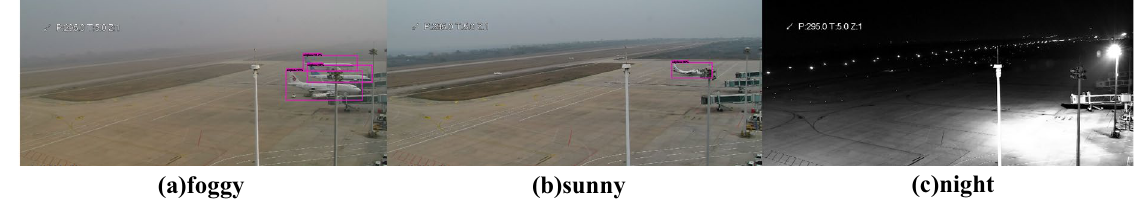
Figure 11. YOLOX-Nano detection renderings in different